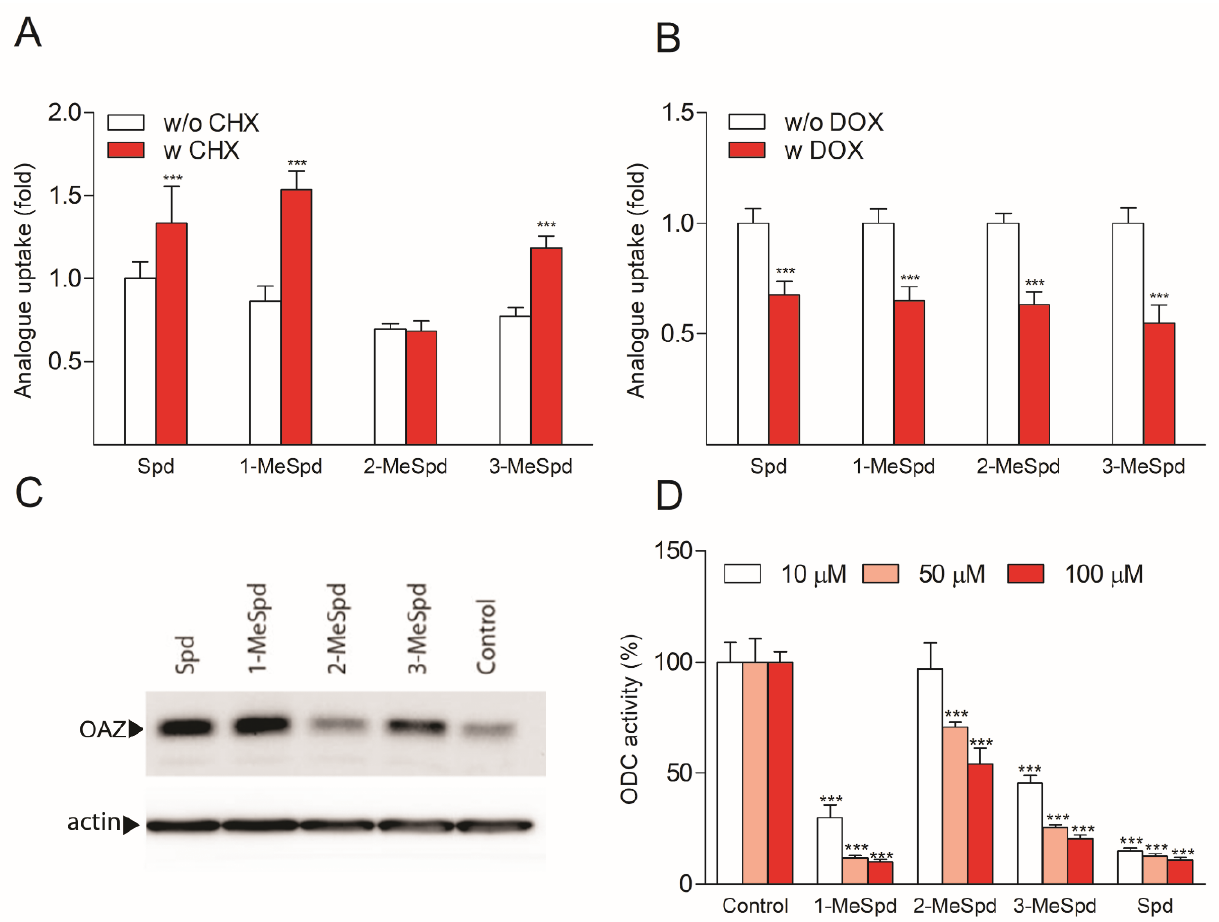
Figure 3. 2-MeSpd is the weakest inducer of OAZ1 synthesis and the weakest downregulator of ODC in DU145 cells. ( A ) Uptake of Spd and its analogues in CHX-treated DU145 cells. After 2 h preincubation with CHX (100 µ g/mL), the compounds (100 µ M) were added, and incubation continued for 4 h before the analysis of the intracellular analogue concentration. ( B ) Uptake of Spd and its analogues in OAZ1-overexpressing DU145 cells. OAZ1 was induced by 24 h preincubation with DOX (250 ng/mL). The compounds (100 µ M) were added for further 6 h before the analysis of intracellular analogue concentration. ( C ) Effect of Spd and the analogues on OAZ1 protein levels in DU145 cells. The cells were incubated for 4 h with 100 µ M analogues in the presence of the proteasomal inhibitor, MG132 (25 µ M). ( D ) Effect of Spd and the analogues on ODC activity in DU145 cells. The cells were incubated with the analogues or Spd for 6 h, after which the cells were harvested for measurements of ODC activity. All plates ( A – D ) were supplemented with 1 mM aminoguanidine (AG, an inhibitor of serum amino oxidases) to prevent the degradation of Spd to toxic metabolites. Results are means ± SD, n = 3 biologically independent samples, representative of n = 3 independent experiments. *** refers to the statistical significance of p < 0.001.